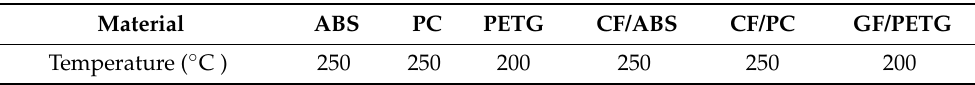
Table 5. Maximum temperature for the DSC